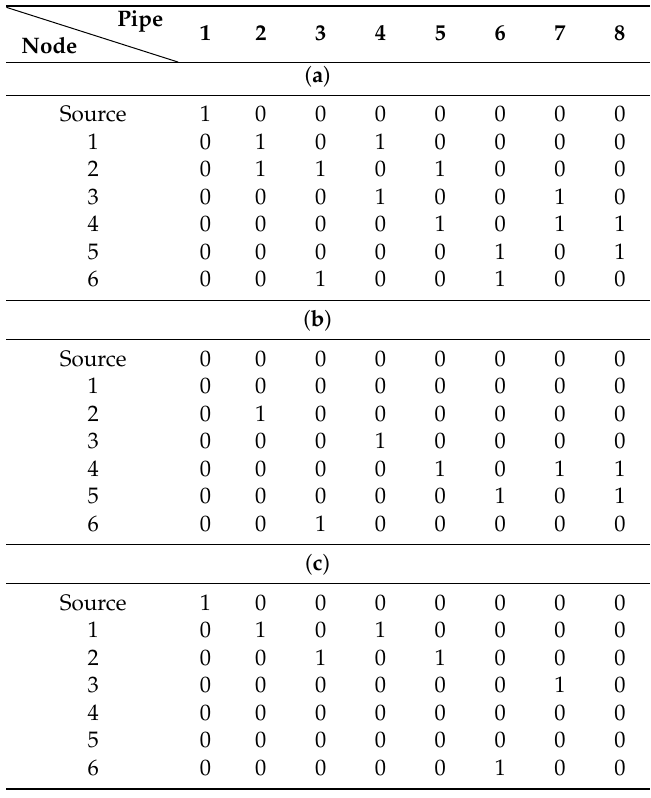
Table 2. Three segment-identifying matrices: ( a ) Node-Arc Matrix; ( b ) Valve Location Matrix; ( c ) Valve Deficiency